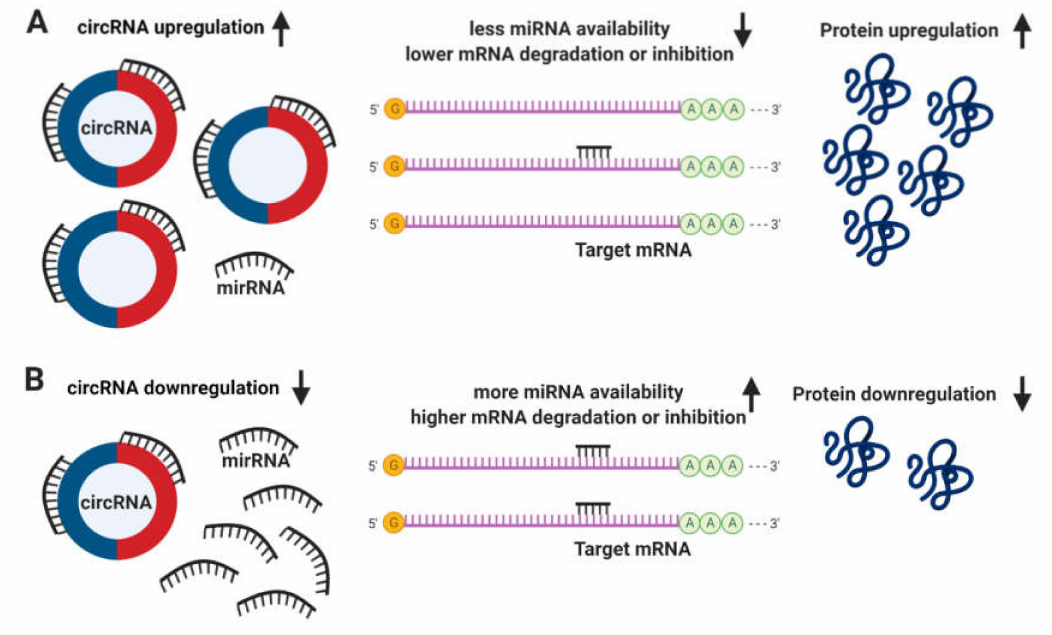
Figure 4. Circular RNA (circRNA) functions. ( A ) The upregulation of circRNAs leads to a decrease in microRNA (miRNA) availability, messenger RNA (mRNA) degradation or inhibition, resulting in an increase of protein translation. ( B ) Conversely, the downregulation of circRNAs leads to more miRNA available and higher levels of mRNA degradation or inhibition, leading to a downregulation in protein